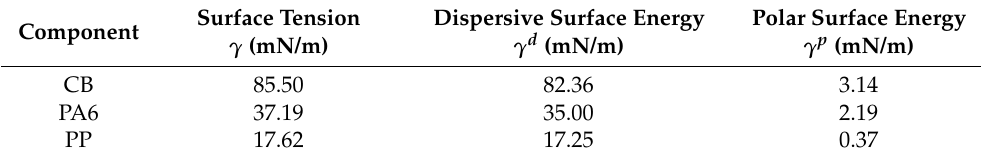
Table 1. Surface tension of PP, PA6 and carbon black (CB) at 230 ◦ C [33].